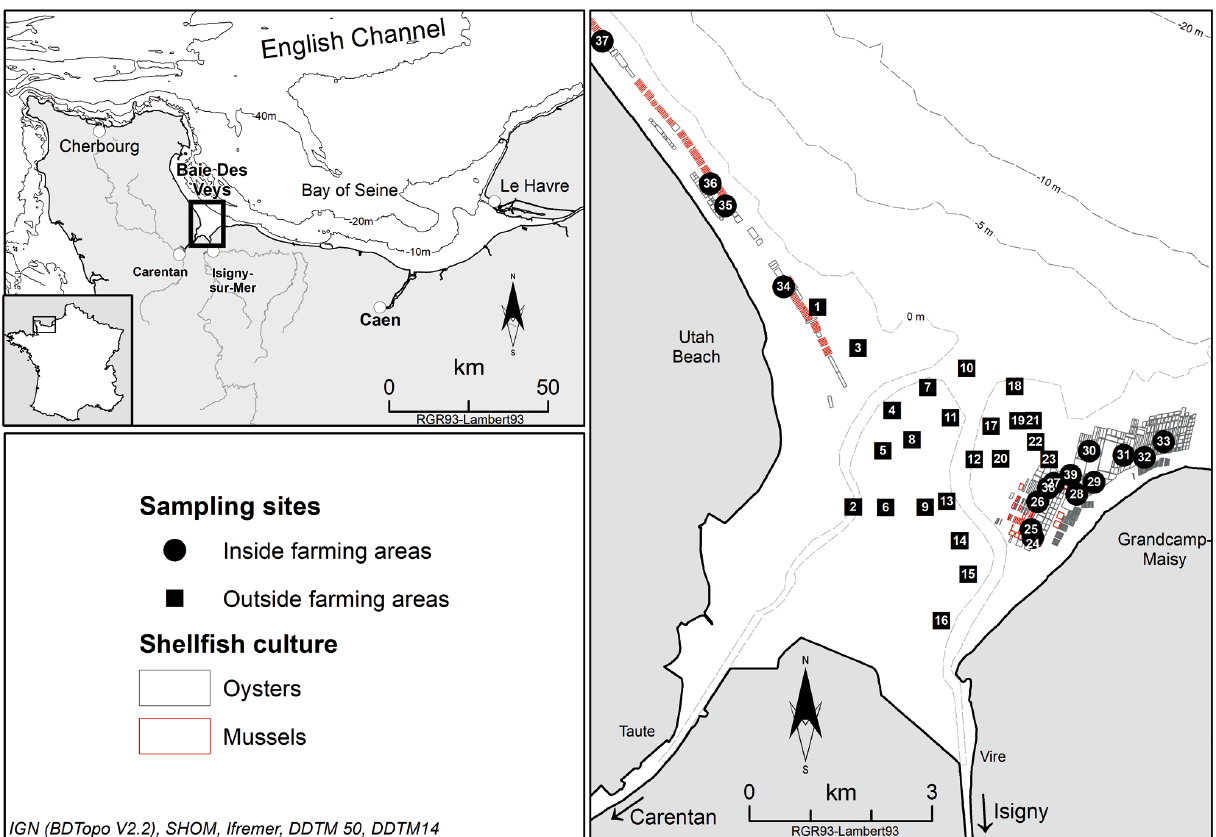
Fig. 1. Baie des Veys. Young (<1 yr) and adult Pacific oysters were deployed at 23 sites located outside shellfish farming areas (Sites 1−23, black squares) and at 16 sites located within 2 bivalve farming areas (black circles), namely Grandcamp (Sites 24−33, 38 and 39) and Utah Beach (Sites